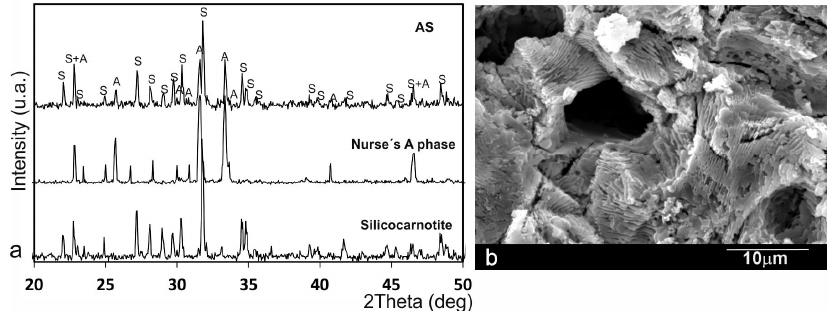
Figure 1. ( a ) X-ray diffraction patterns of the synthesised silicocarnotite and Nurse´s A materials and the AS eutectoid ceramic; ( b ) Scanning Electron Microscopy (SEM) image of the biphasic ceramic microstructure with a lamellae morphology.